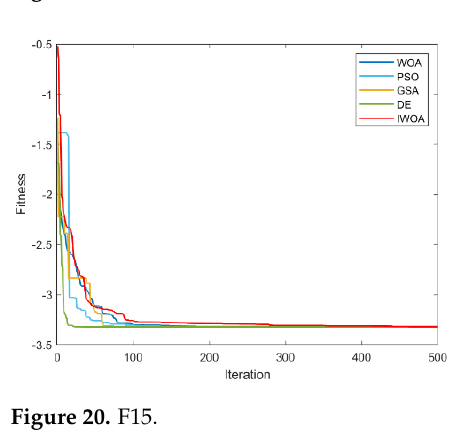
Figure 19. F14. Figure 19. F14.